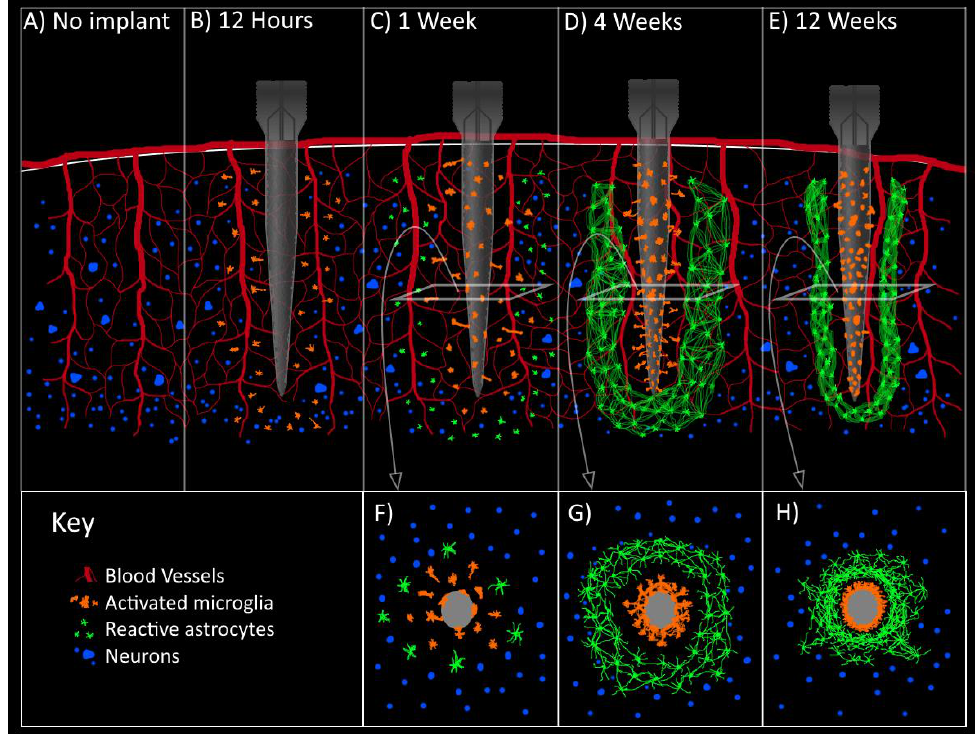
Figure 3. Illustration of the glial encapsulation response ( A ) prior to implantation, ( B ) 12 h post- implantation, ( C ) 1 week post-implantation, ( D ) 4 weeks post-implantation, and ( E ) 12 weeks post- implantation. Panels ( F ), ( G ), and ( H ) represent cross sectional views of ( C ), ( D ), and ( E ), respectively.